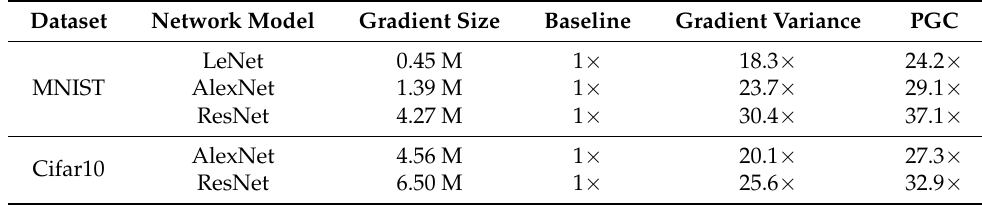
Table 3. Compression ratio information.